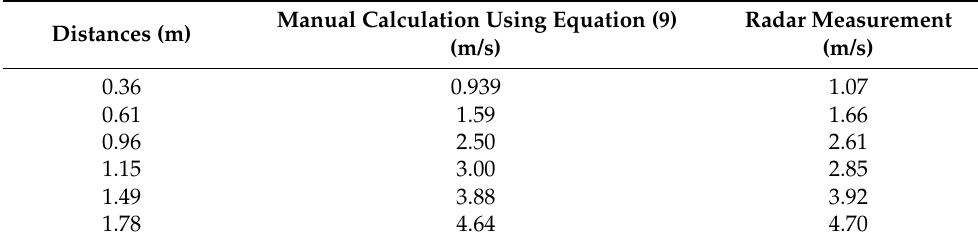
Figure 1. The frequency of FMCW radar with time (fast chirp signal). Tx is the transmitted signal, Rx is the received signal, T is the period, and B is the bandwidth. Table 1. Velocity comparison at different distances. Table 1. Velocity comparison at different